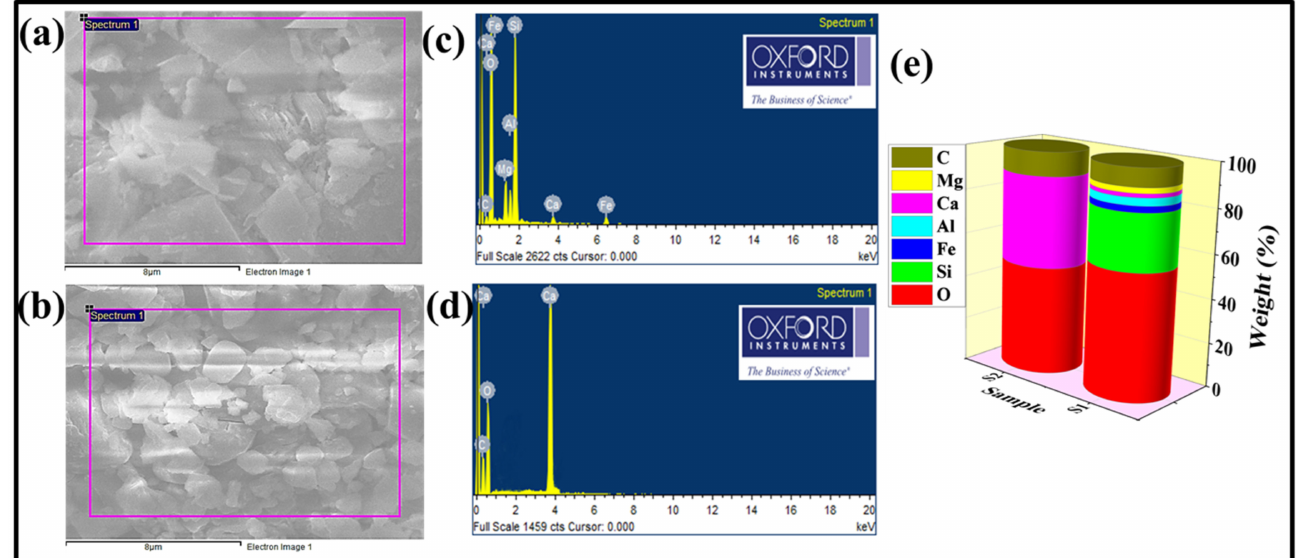
Figure 2. FESEM-EDX analysis of the studied samples: ( a ) SEM image of S1, ( b ) SEM image of S2, ( c ) EDX image of S1, ( d ) EDX image of S2, and ( e ) elemental composition of S1 and